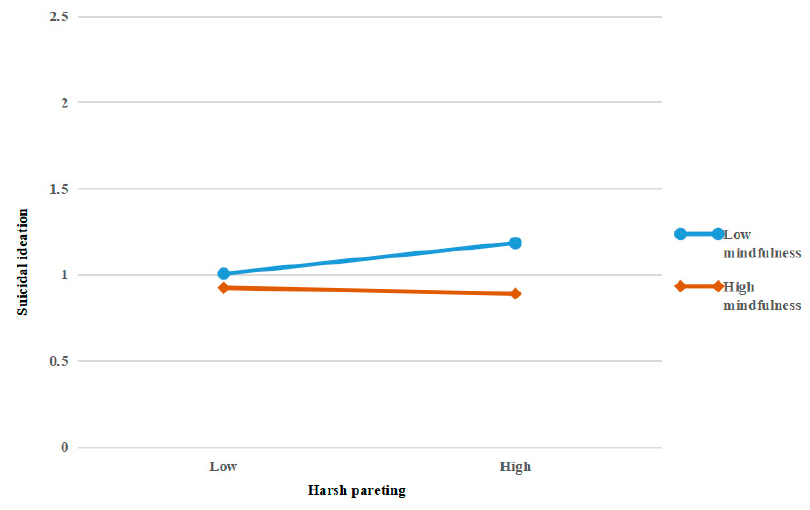
Figure 2. Interaction of mindfulness and harsh parenting on suicidal ideation.